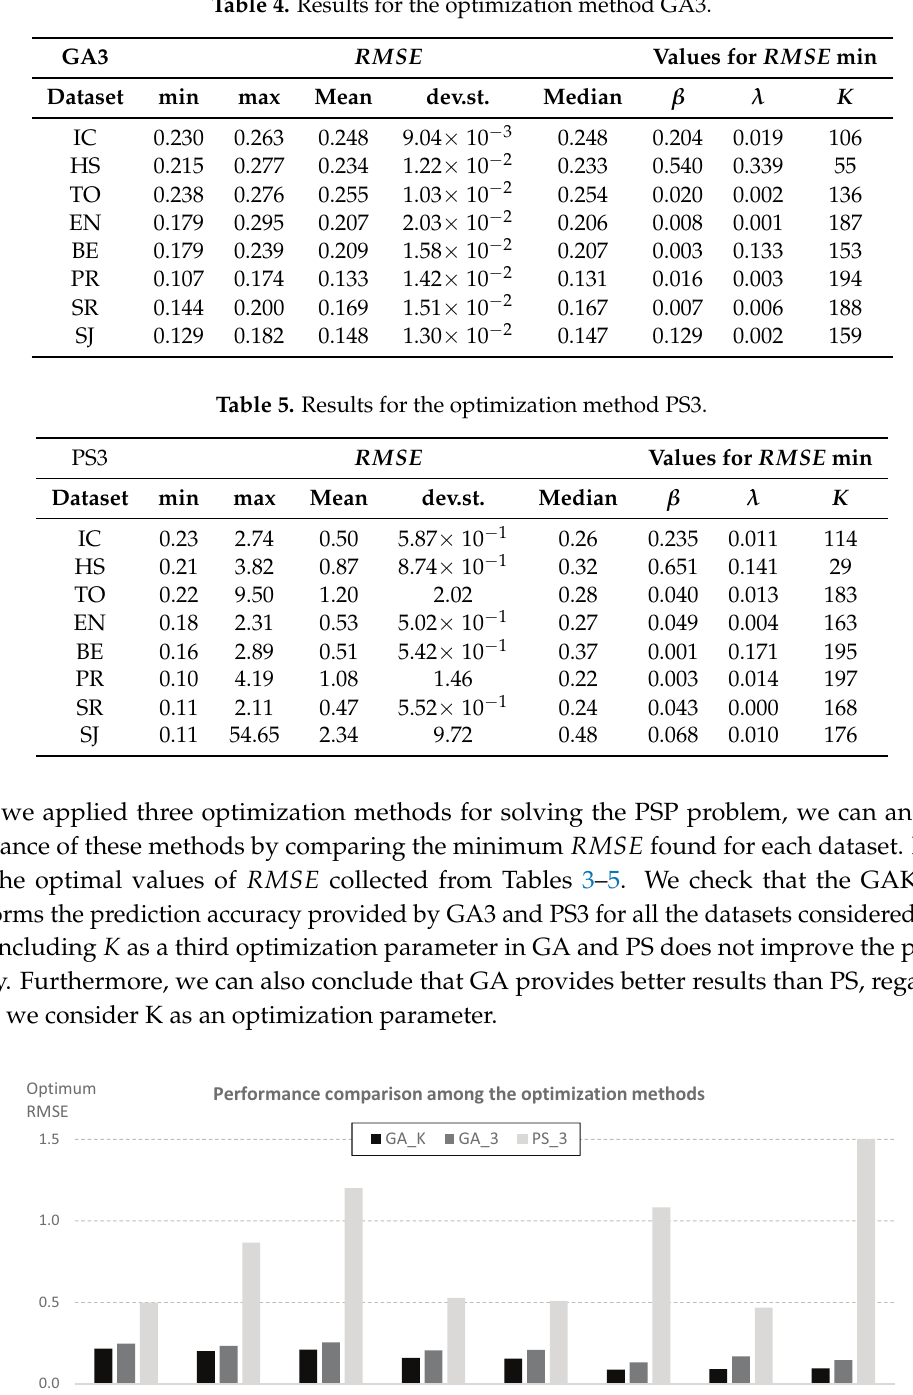
Table 4. Results for the optimization method GA3.